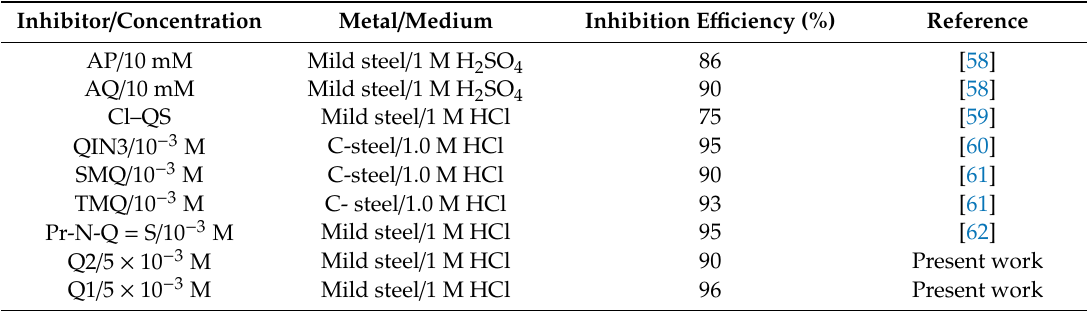
Table 7. Quantitative comparison of the inhibition e ffi ciency of Q1 and Q2 with the literature data based on other quinoxaline derivatives studied previously.